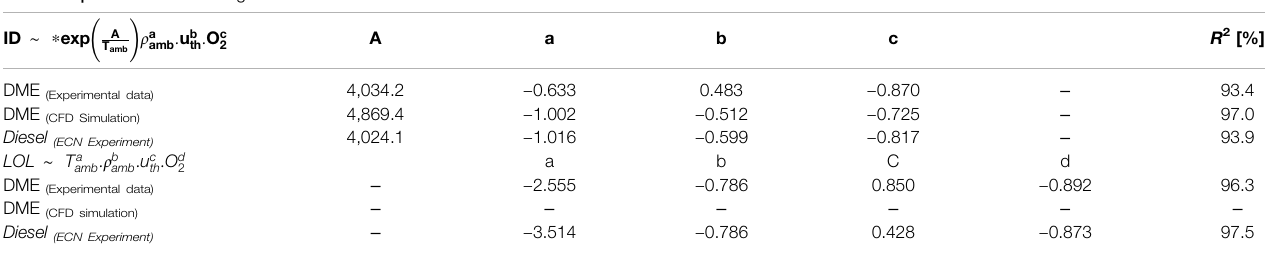
TABLE 2 | Coef fi cients from regression model of ID and LOL for DME and